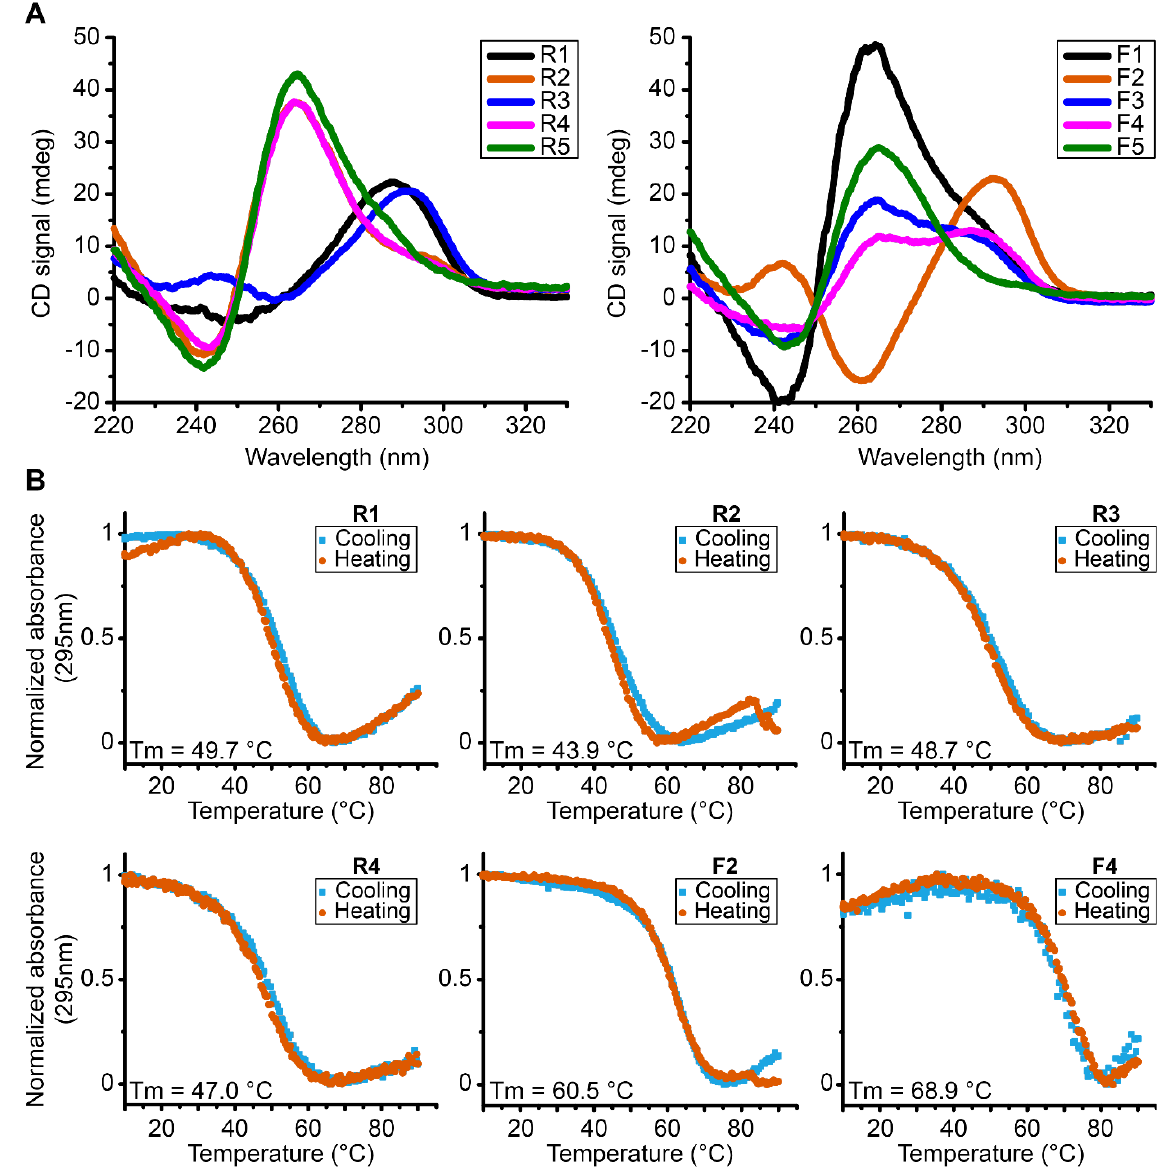
Figure 2. ( A ) CD spectra of reverse and forward MST1R G4 forming sequences at 37 °C exhibiting parallel (R2, R4, R5, F1 and F5), antiparallel (F2), hybrid conformation (F3, F4) and a partial antiparallel or mixture (R1 and R3). ( B ) UV-melting spectra of reverse and forward MST1R G-quadruplexes forming sequences at 295 nm from 10 °C to 90 °C. All experiments were performed in buffer 1× (50 mM KCl; 10 mM KPi; pH 6.6).